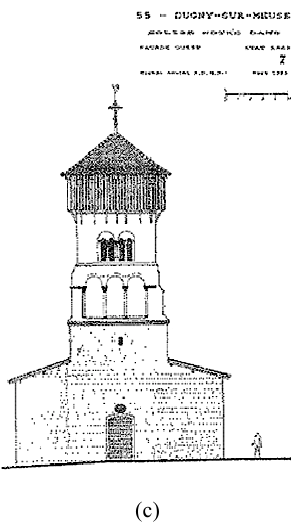
Figure 2. Existing documentation of the church (Michel Goutal, 1988): (a) longitudinal sectional view; (b) north façade;